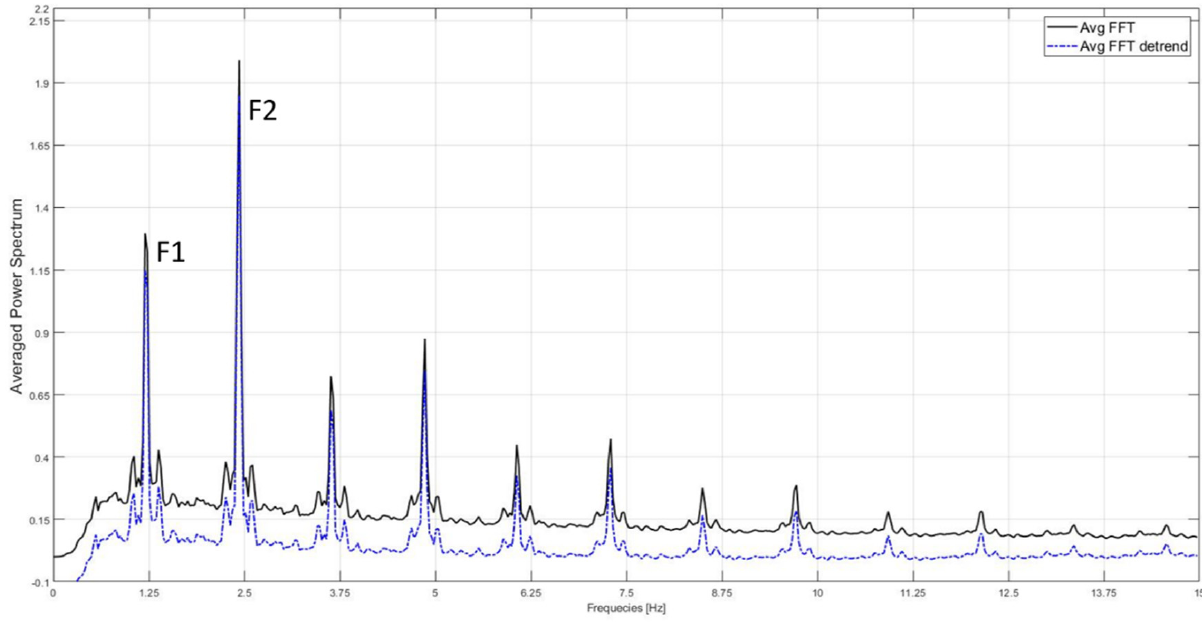
Figure 1. The Averaged Power Spectrum of a representative subject (black curve). The blue dashed line shows the signal after the application of the detrend Matlab function to remove the effect of the flickering noise. The two largest peaks correspond to stride frequency (F1) and cadence (F2).